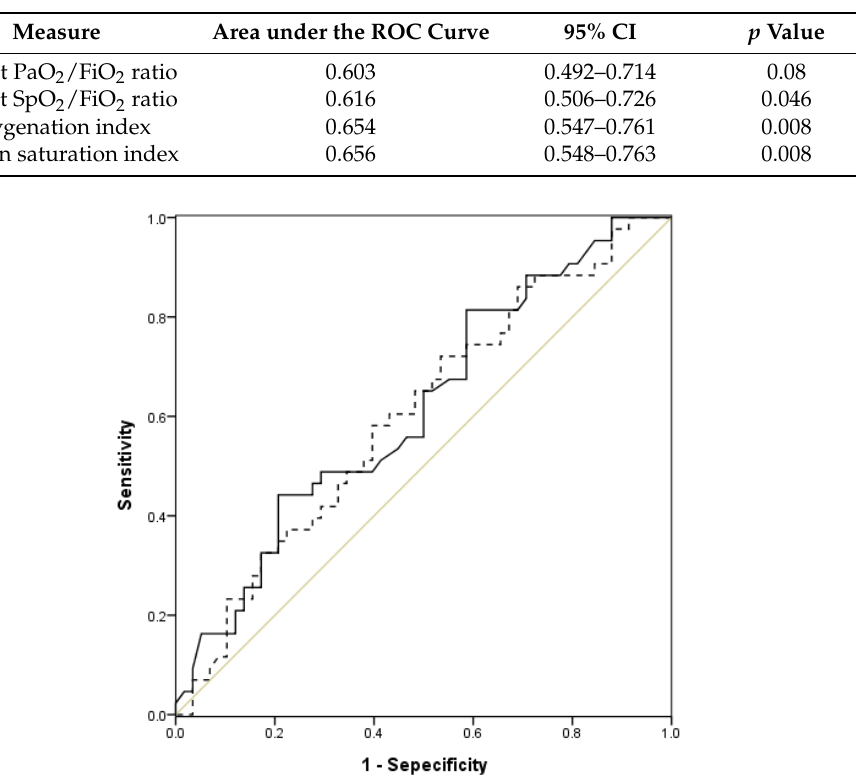
Figure 1. Receiver-operative characteristics (ROC) curves of oxygenation saturation index (continuous line) and oxygenation index (dotted line) for mortality prediction.